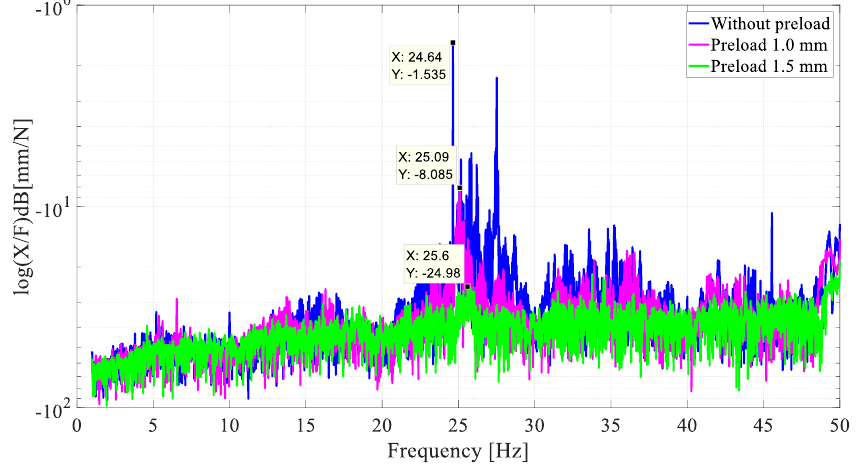
Figure 17. FRF of the system with and without preload.